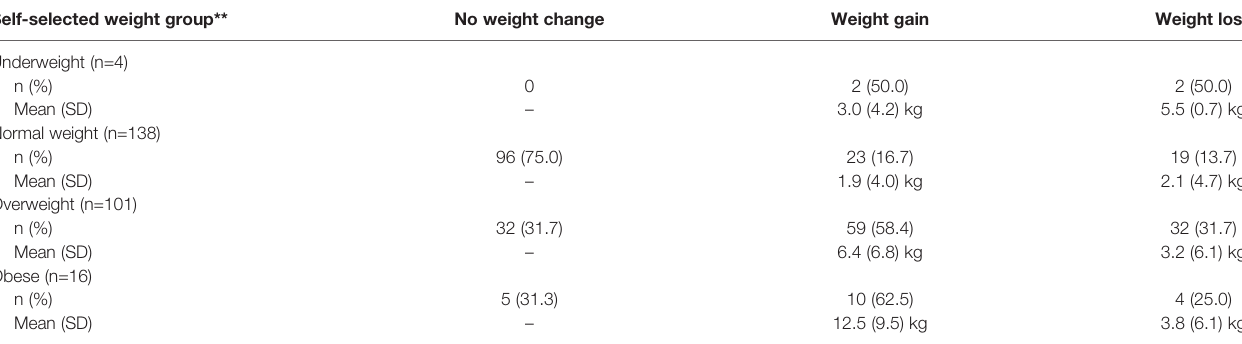
TABLE 2 | Descriptive data showing distribution of “ no weight change ” , “ weight gain ” and “ weight loss ” in new fi tness club members the past 12 months according to self-selected weight group